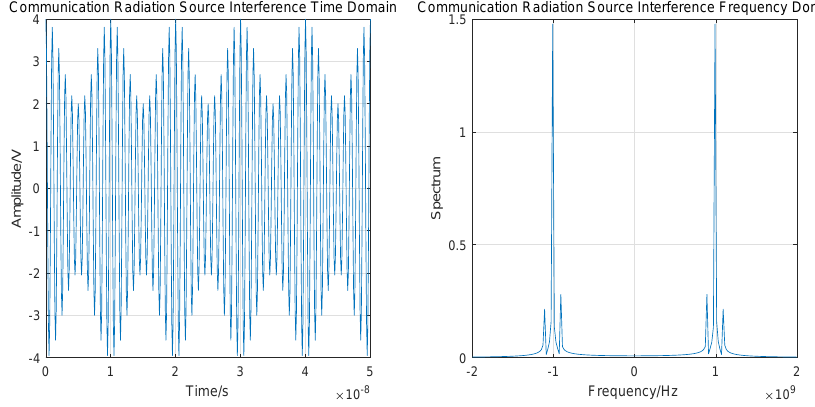
Figure 8. CRS interference time–frequency domain